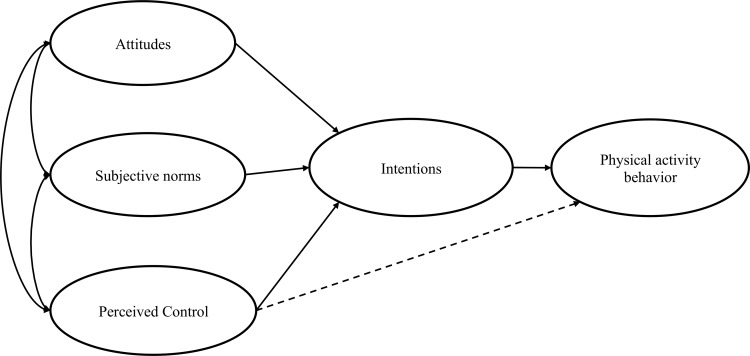
The theory of planned behavior (Ajzen, 2012).